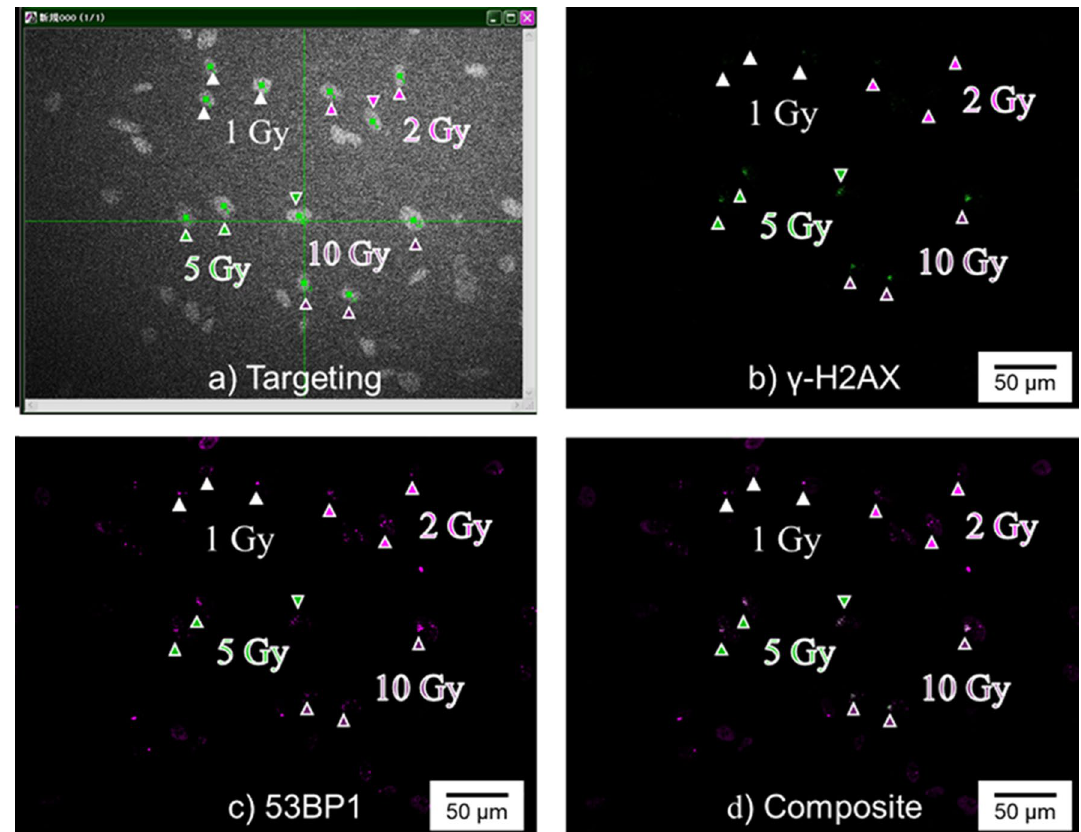
Figure 5. Accumulation of p53-binding protein 1 (53BP1) and phosphorylated histone H2AX (γ-H2AX) foci in nucleus-irradiated WI-38 cells after 30 min of irradiation. ( a ) The nucleus of each of the three WI-38 cells on the same dish was irradiated with 1, 2, 5, or 10 Gy 5 × 5 µm beams. Green squares symbolize the targeted positions. ( b ) γ-H2AX foci formation at the irradiated sites. ( c ) 53BP1 foci formation at the irradiated sites. ( d ) Composite of ( b ) and ( c ). The arrows in each panel indicate the position of irradiated nuclei. 53BP1 and γ-H2AX foci formations in the captured images are presented as magenta and green signals, respectively. The dose deposited in each nucleus is shown in each